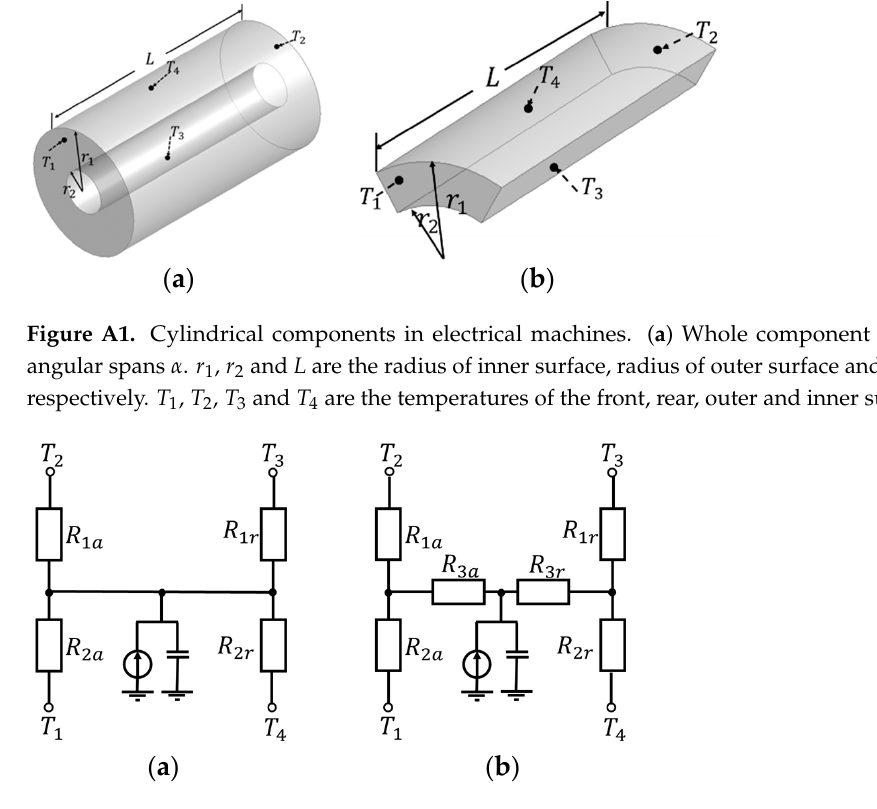
Figure A2. Equivalent LPTN for cylindrical components. ( a ) Without and ( b ) with heat